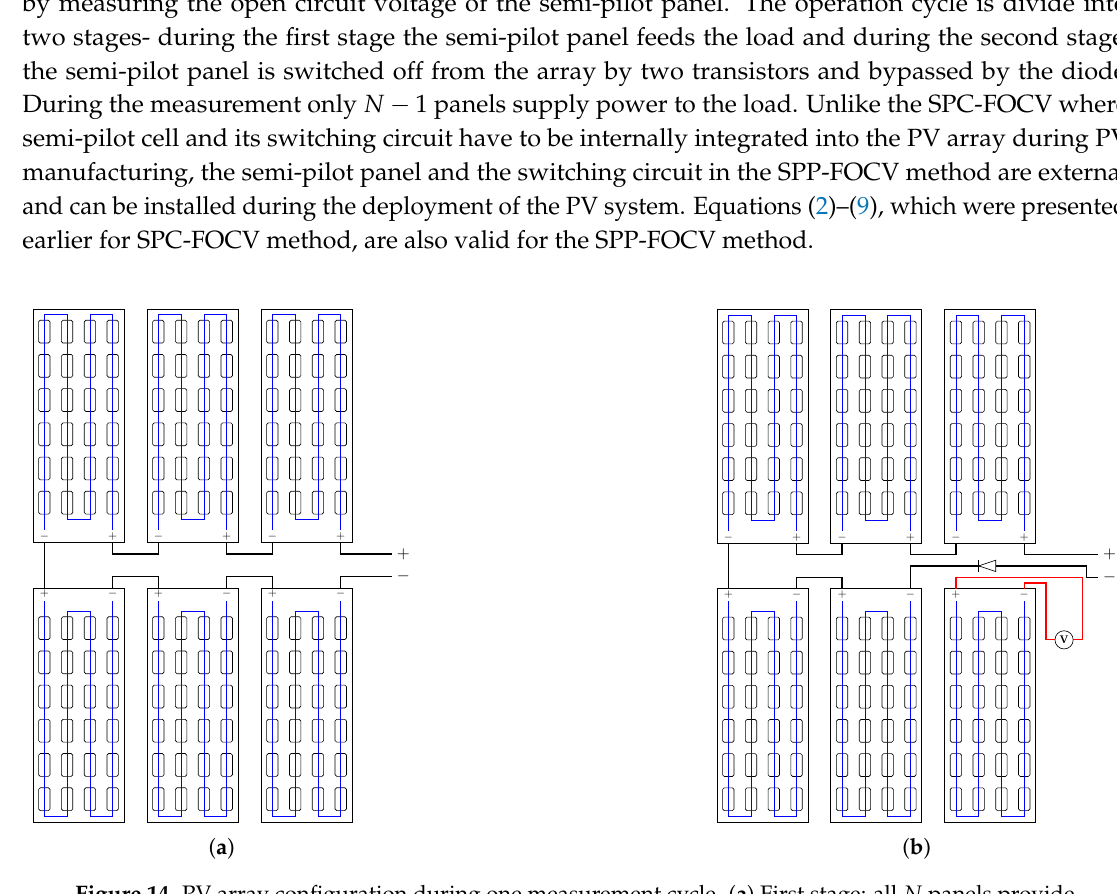
Figure 14. PV array configuration during one measurement cycle. ( a ) First stage: all N panels provide power to the load, semi-pilot panel is connected to the array; ( b ) Second stage: the semi pilot panel is disconnected from the